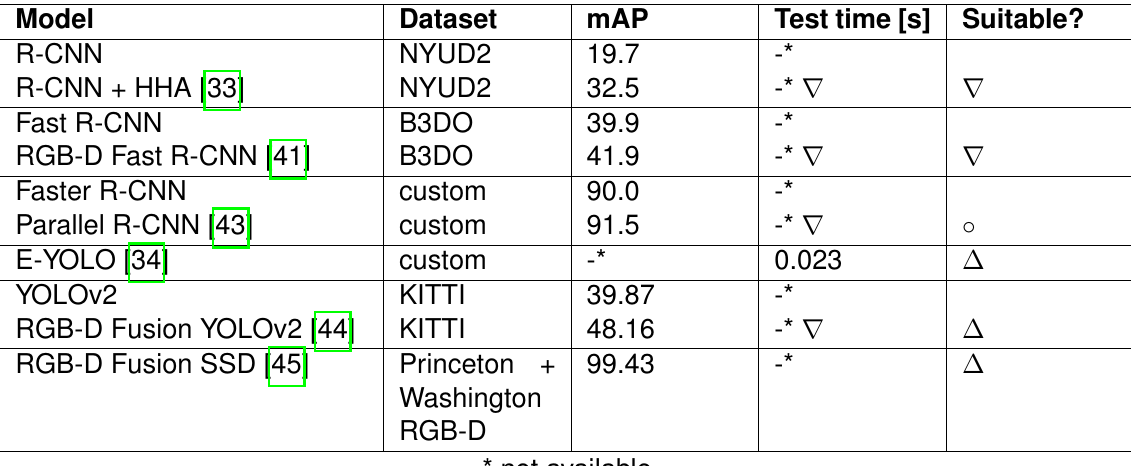
Table 2. Comparison and rating of different RGB-D